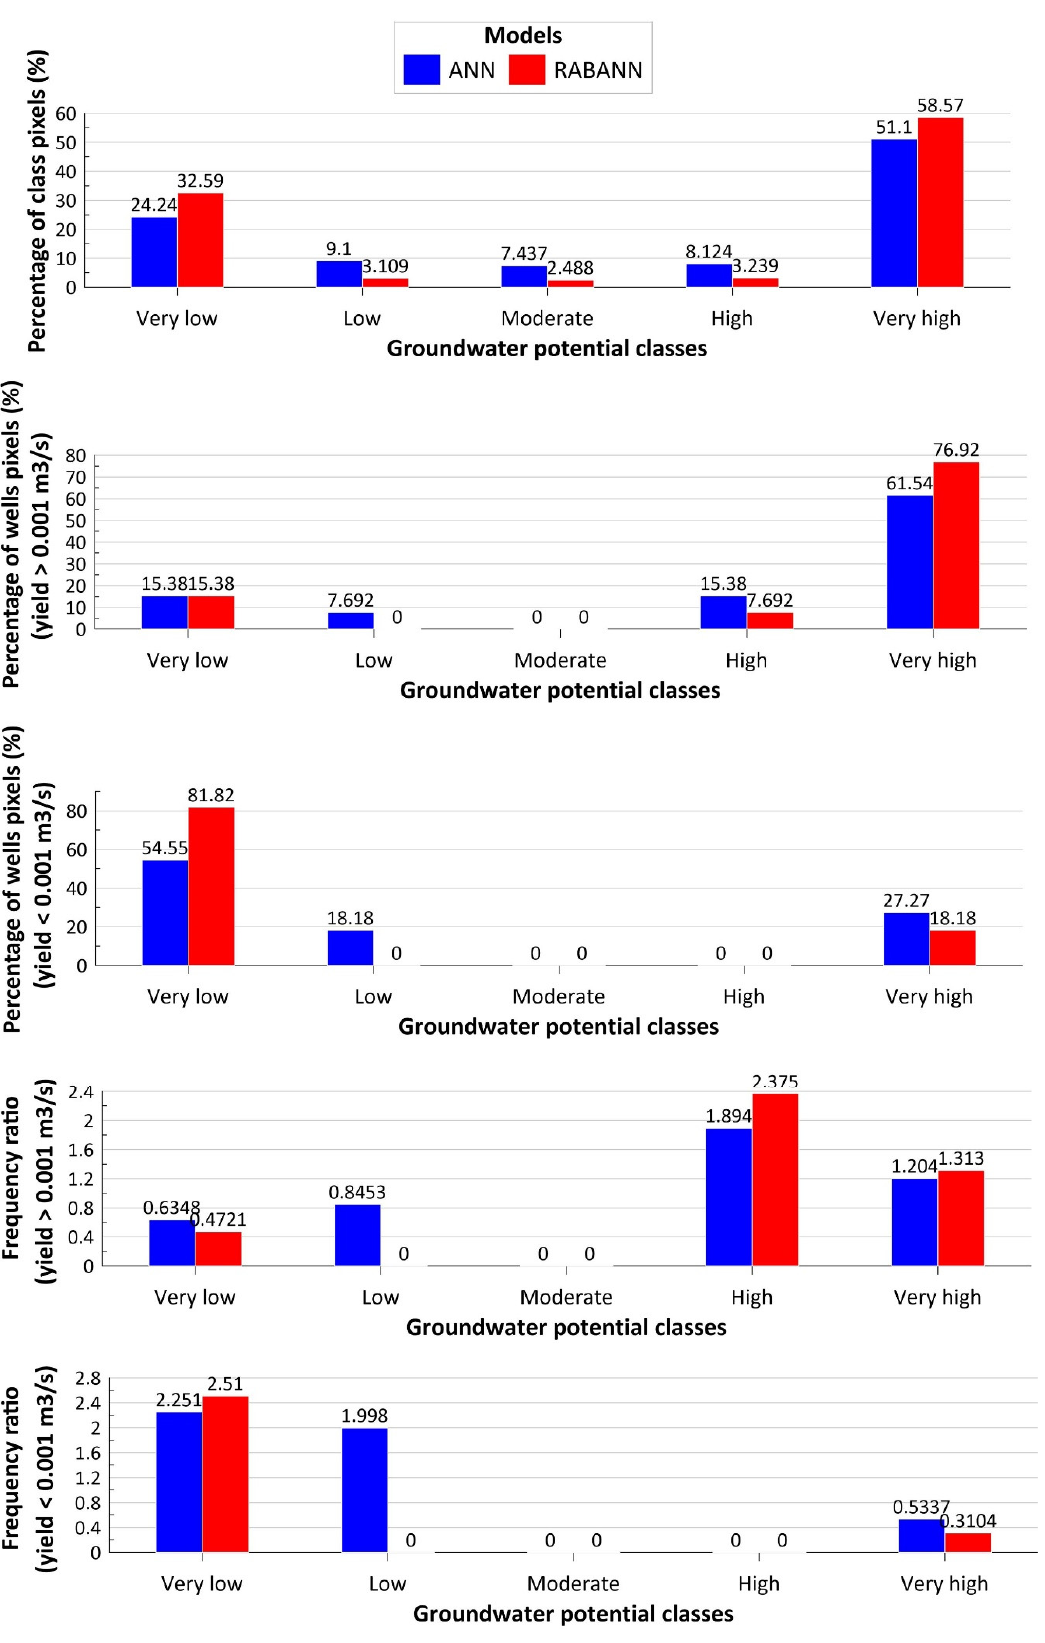
Figure 7. Analysis of the groundwater potential maps.